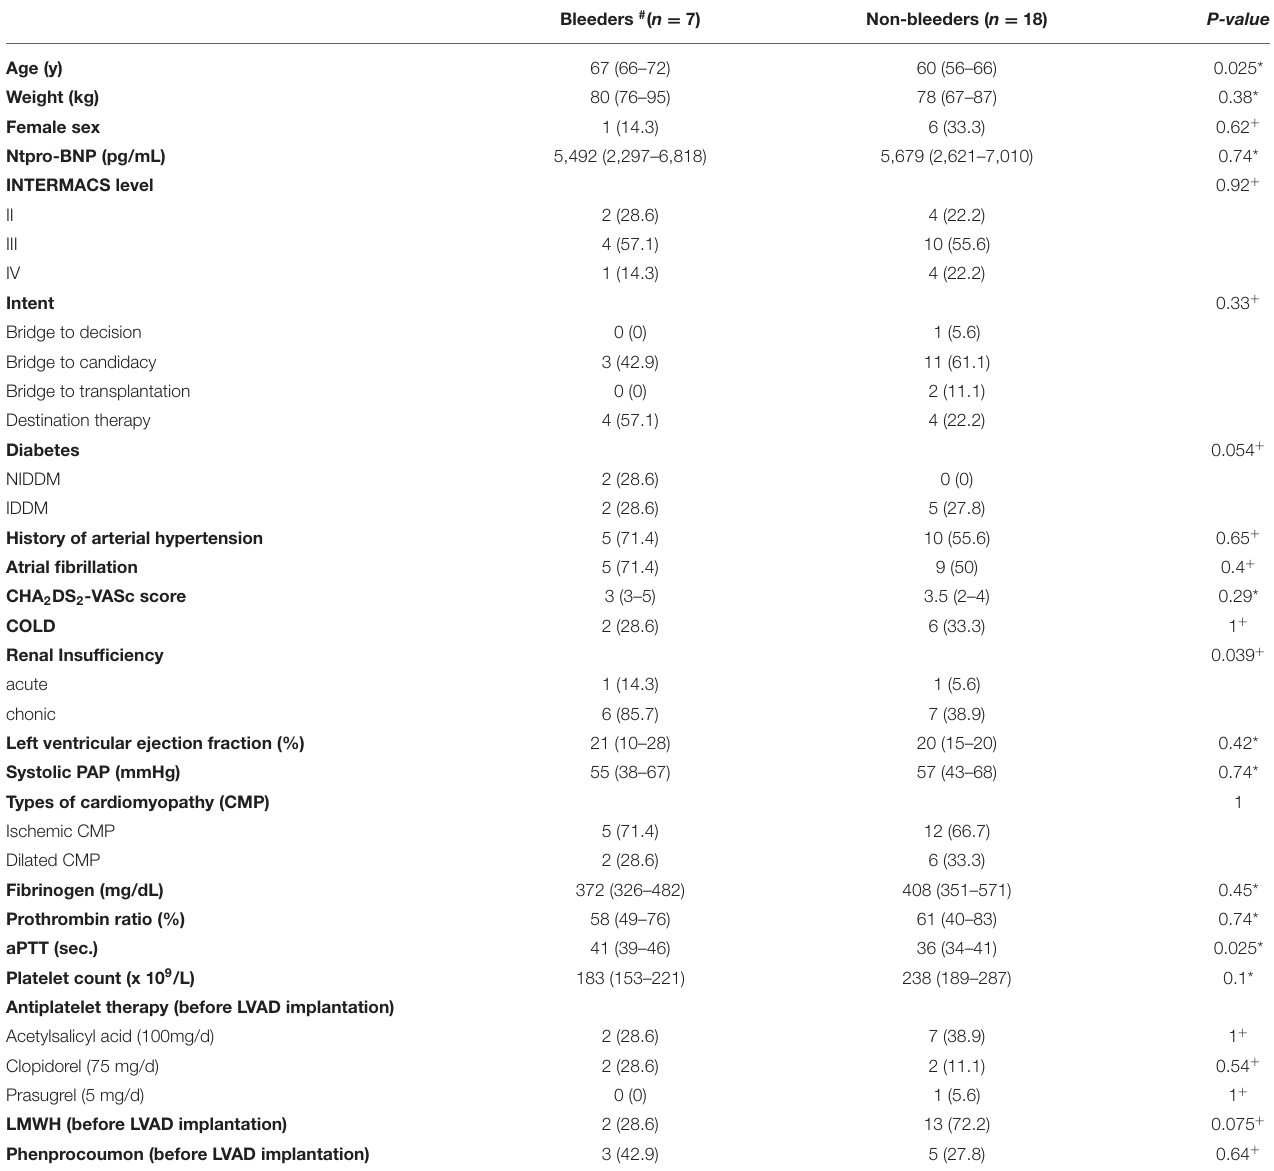
TABLE 1 | Preoperative